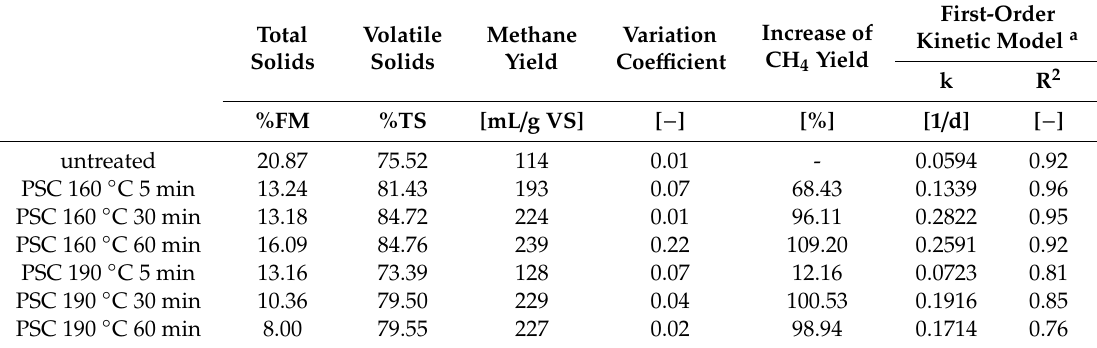
Table 1. Final methane yields of untreated and pressure-swing conditioning (PSC)-treated cattle manure coe ffi cient, increase of methane yield, first-order kinetic constant and coe ffi cient of